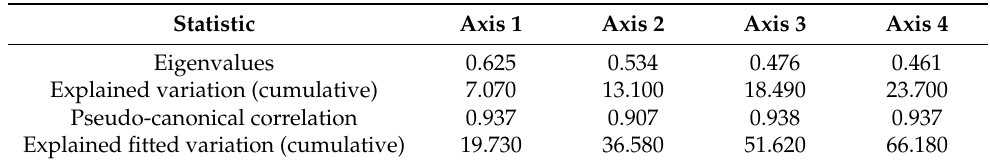
Table 6. Eigenvalues and explained variation of the first four canonical correspondence analysis (CCA) ordination axes of species distribution and environmental variables.